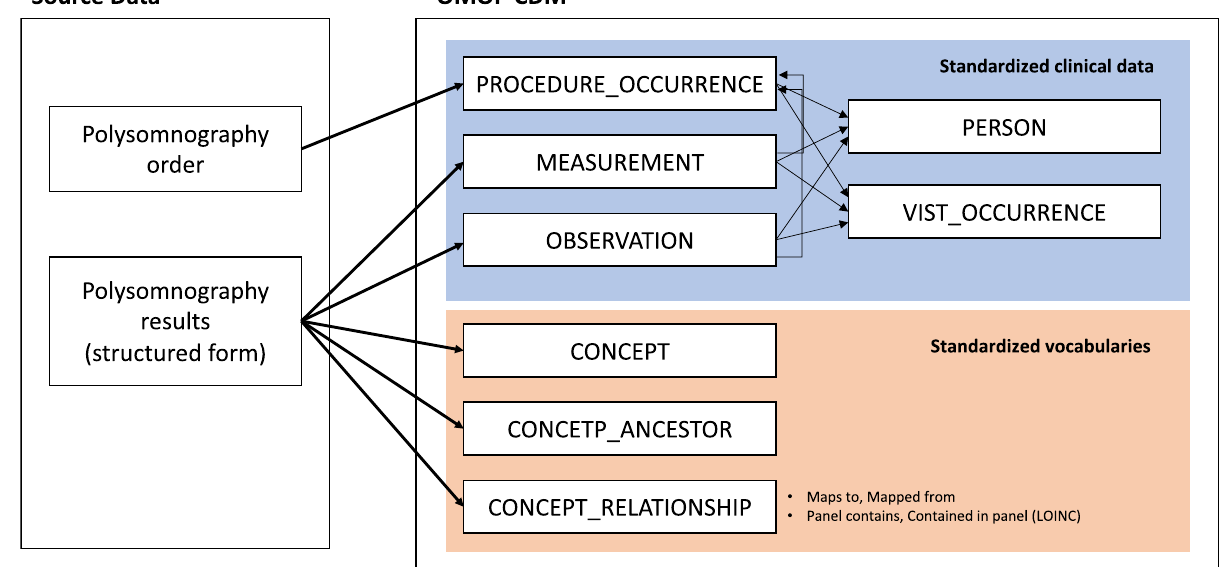
Figure 1. Conversion of polysomnography into the Observational Medical Outcomes Partnership (OMOP) Common Data Model (CDM)